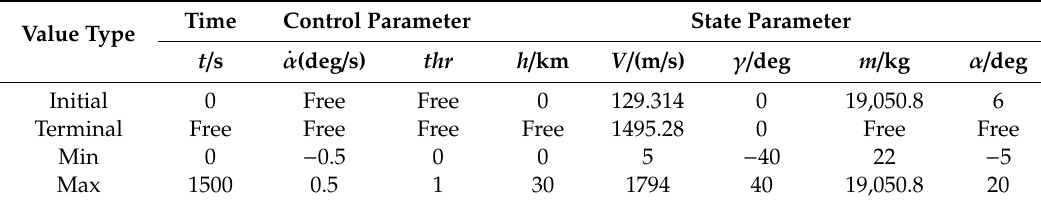
Table 1. Boundary conditions and